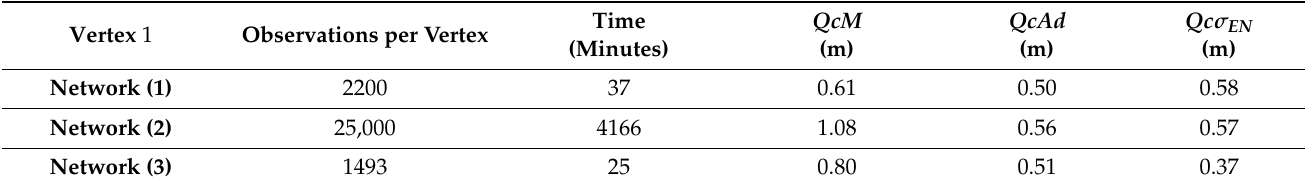
Table 13. The quadratic component QcM of the E, N errors from the mean of the observations. The quadratic component QcAd of the E, N errors from the adjusted coordinates. The quadratic component Qc σ EN of σ E and σ N from expresScheme 35. Vertex